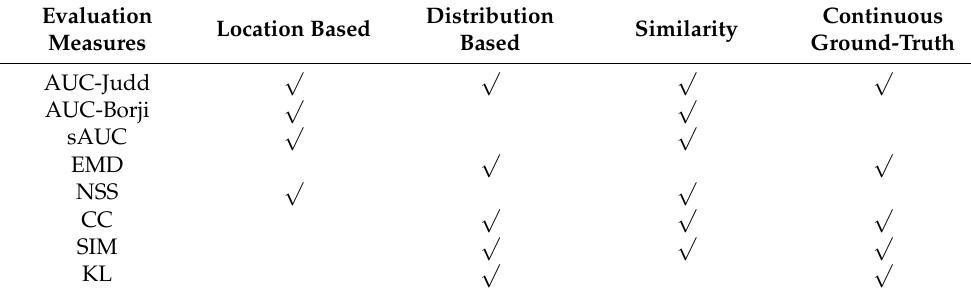
Table 1. Summary of evaluation measures for visual saliency prediction.